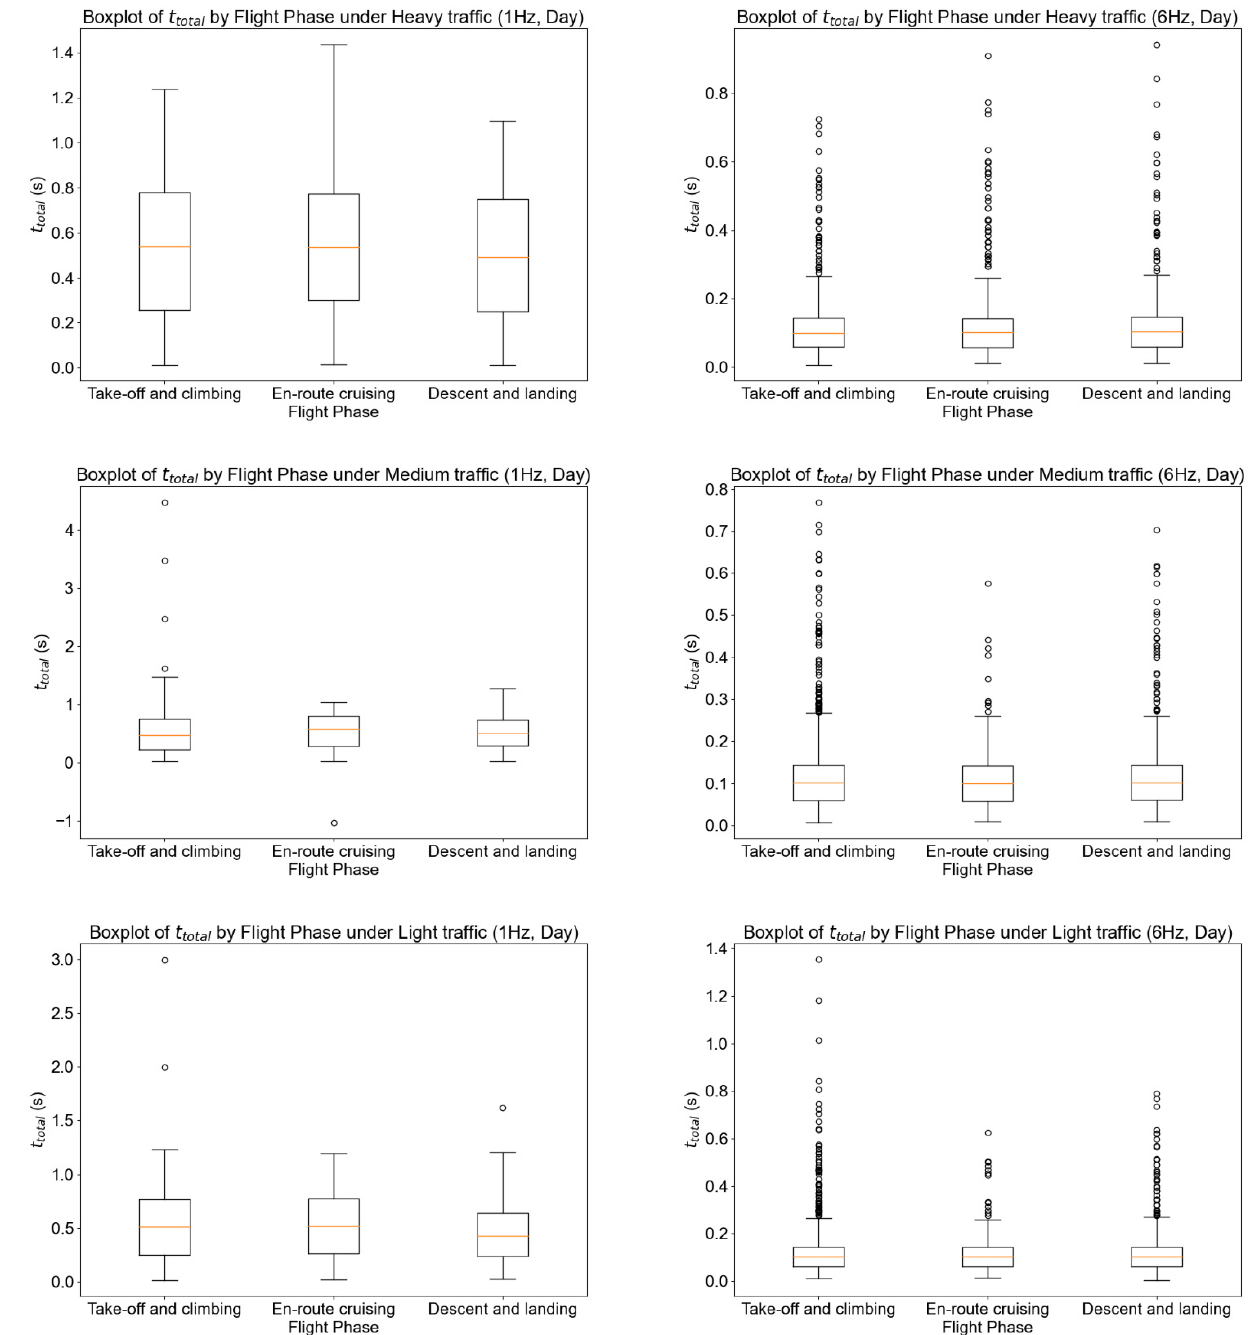
Figure A5. The boxplots of t total during daytime setting.